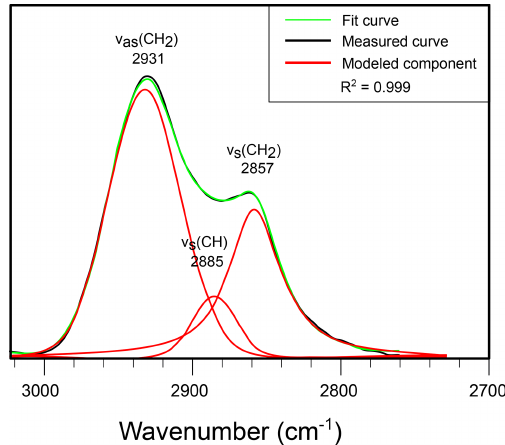
Figure 4. Deconvolution of the CH x absorption bands for the 3100– 2700 cm − 1 region demonstrating the absence of significant CH 3 absorption. Modeled curves are Lorentzian (curve at 2931cm − 1 ) and Gaussian (the other